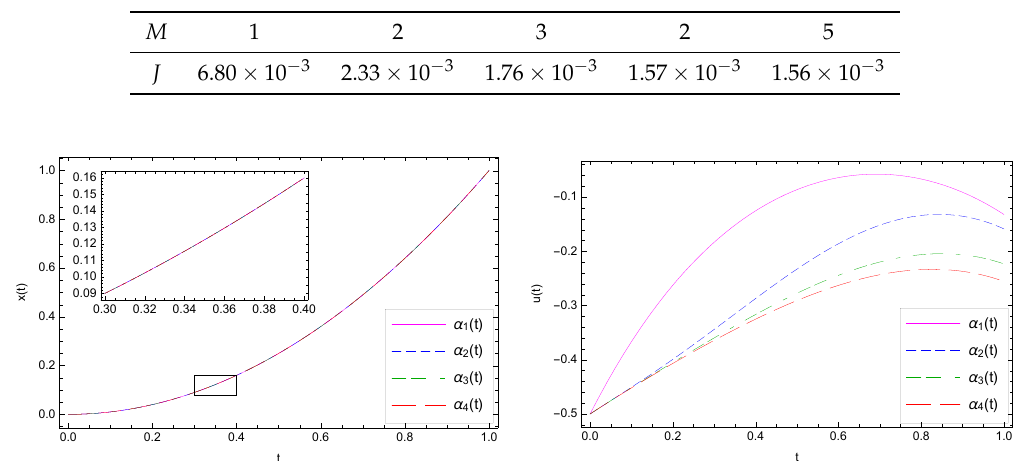
Table 1. (Example 1.) Numerical results obtained by Approach II for the performance index with different M and α ( t ) = sin ( t ) .